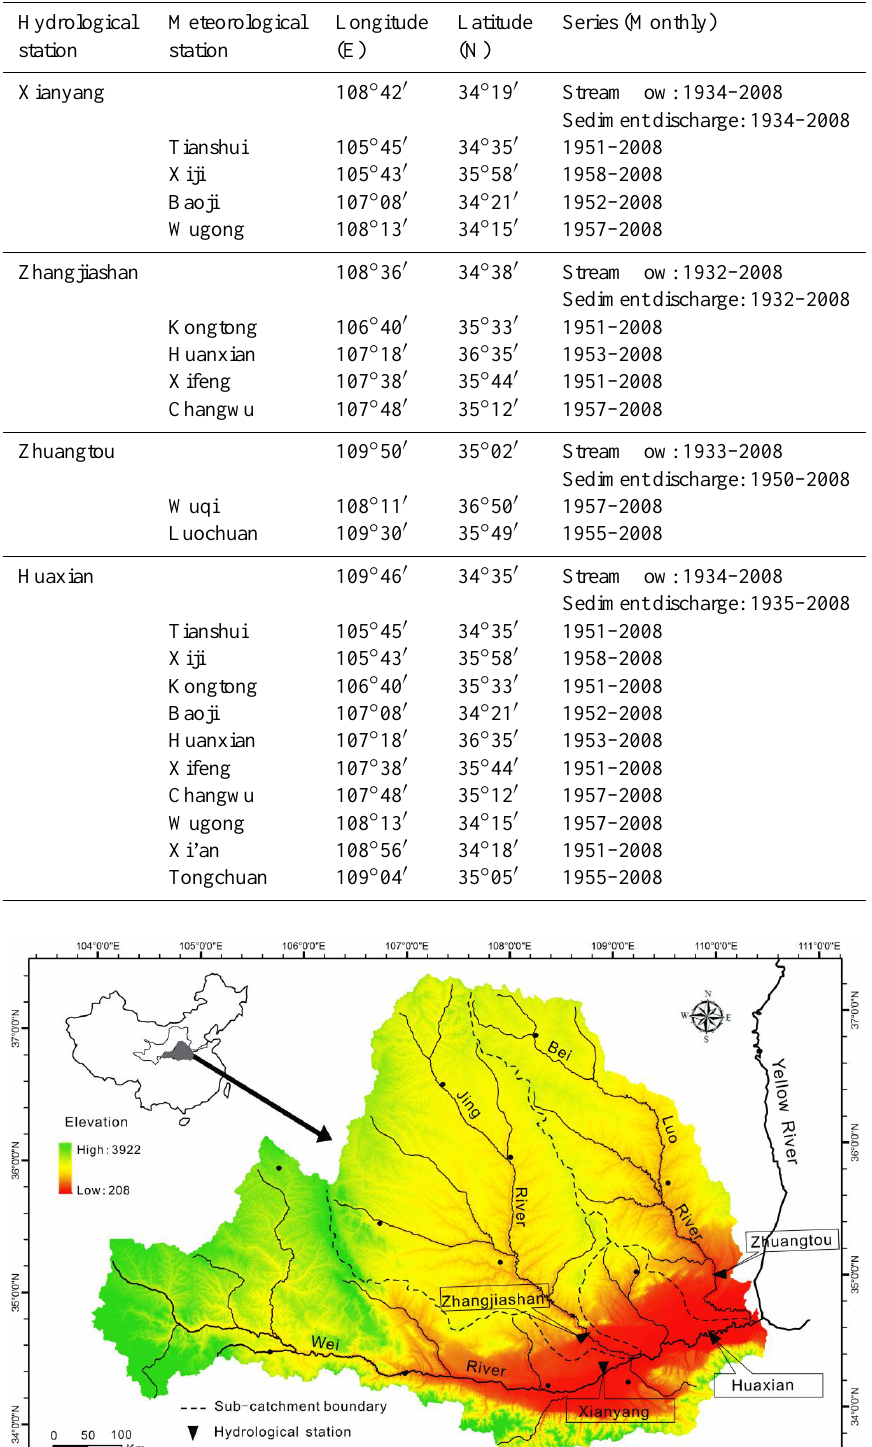
Table 1. The location and data series of the hydrologic and corresponding meteorological stations. Hydrological